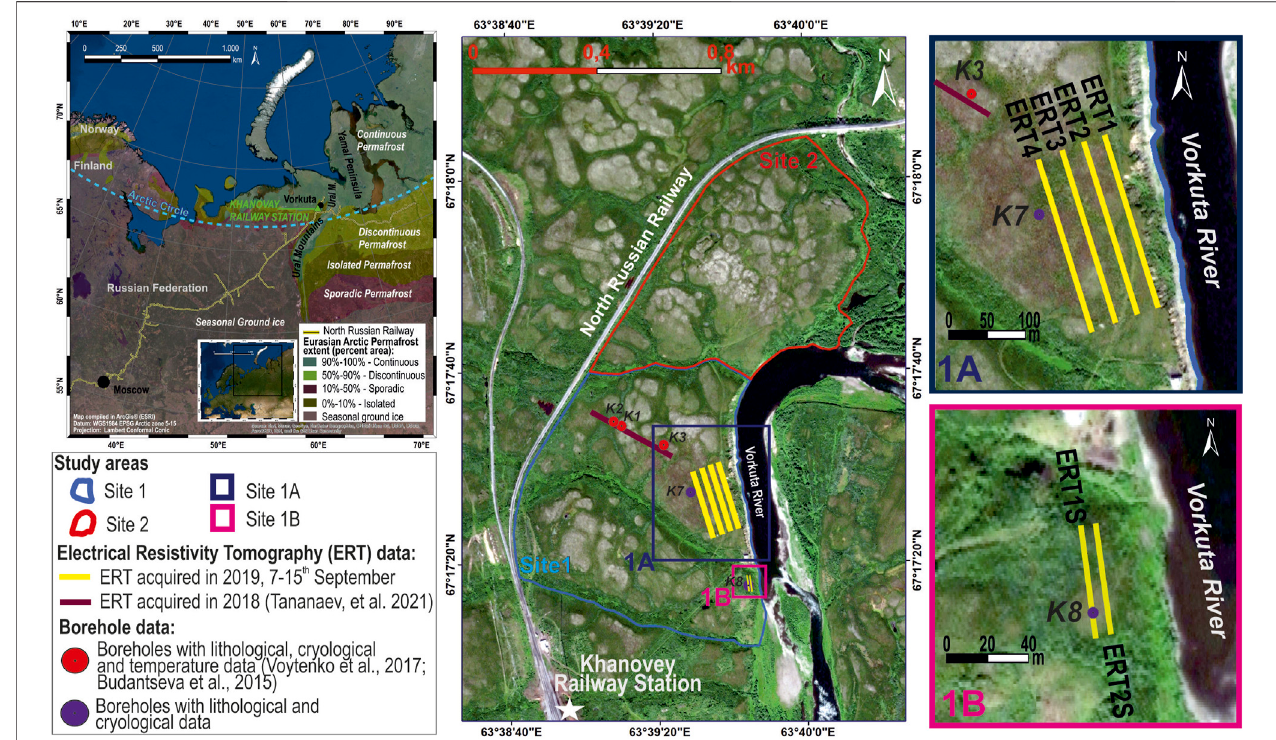
FIGURE1| Thetopleftmapshowsthelocationofthestudyarea(Khanoveyrailwaystation,closetoVorkutacity)intheNEEuropeanRussianArctic,alongwiththe percentage of permafrost lateral continuity in the region (according to the classi fi cation of Brown et al., 1997; Brown et al., 2002). The map at the center of the fi gure shows the survey location area, with the position of boreholes and geophysical data used in this study. The pro fi le positions of the geoelectric surveys performed in 2019 in Site 1A and Site 1B are highlighted in blow-ups on the right. Maps compiled using ArcGis ® (Esri) software. Datum: WGS84; projection: UTM 41N. Satellite base image (Gis layer “ World Imagery ” ) and permafrost extent(Gis layer “ North Hemisphere Permafrost_WFL1 ” ) wereretrieved in 2019 from the ArcGis online database resources.